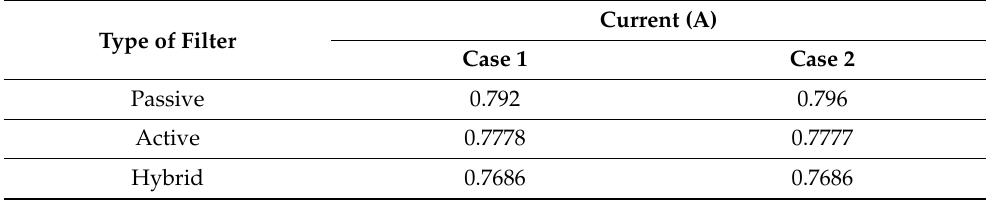
Table 3. Comparative performance of the current using various